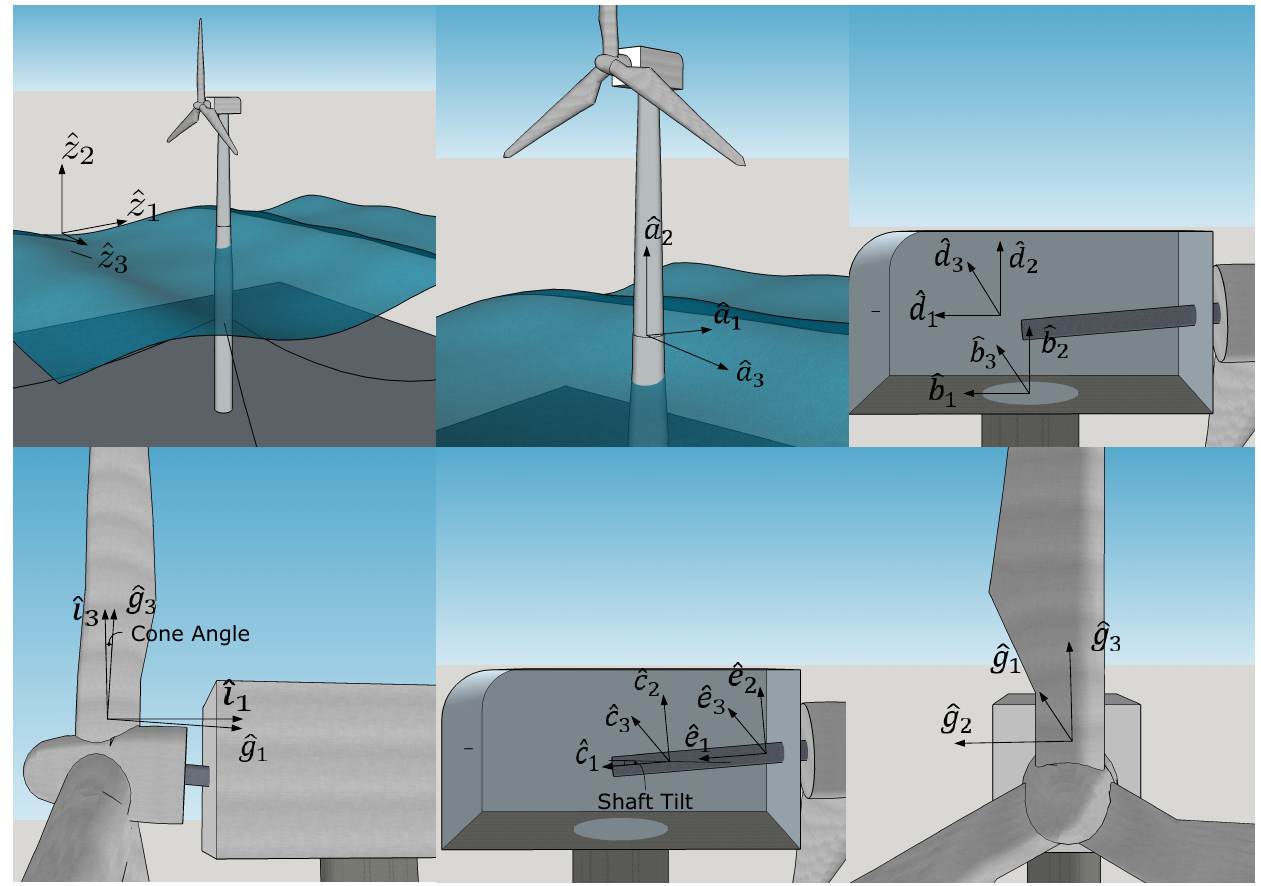
Figure 2. Coordinate systems for Spar Type FOWT